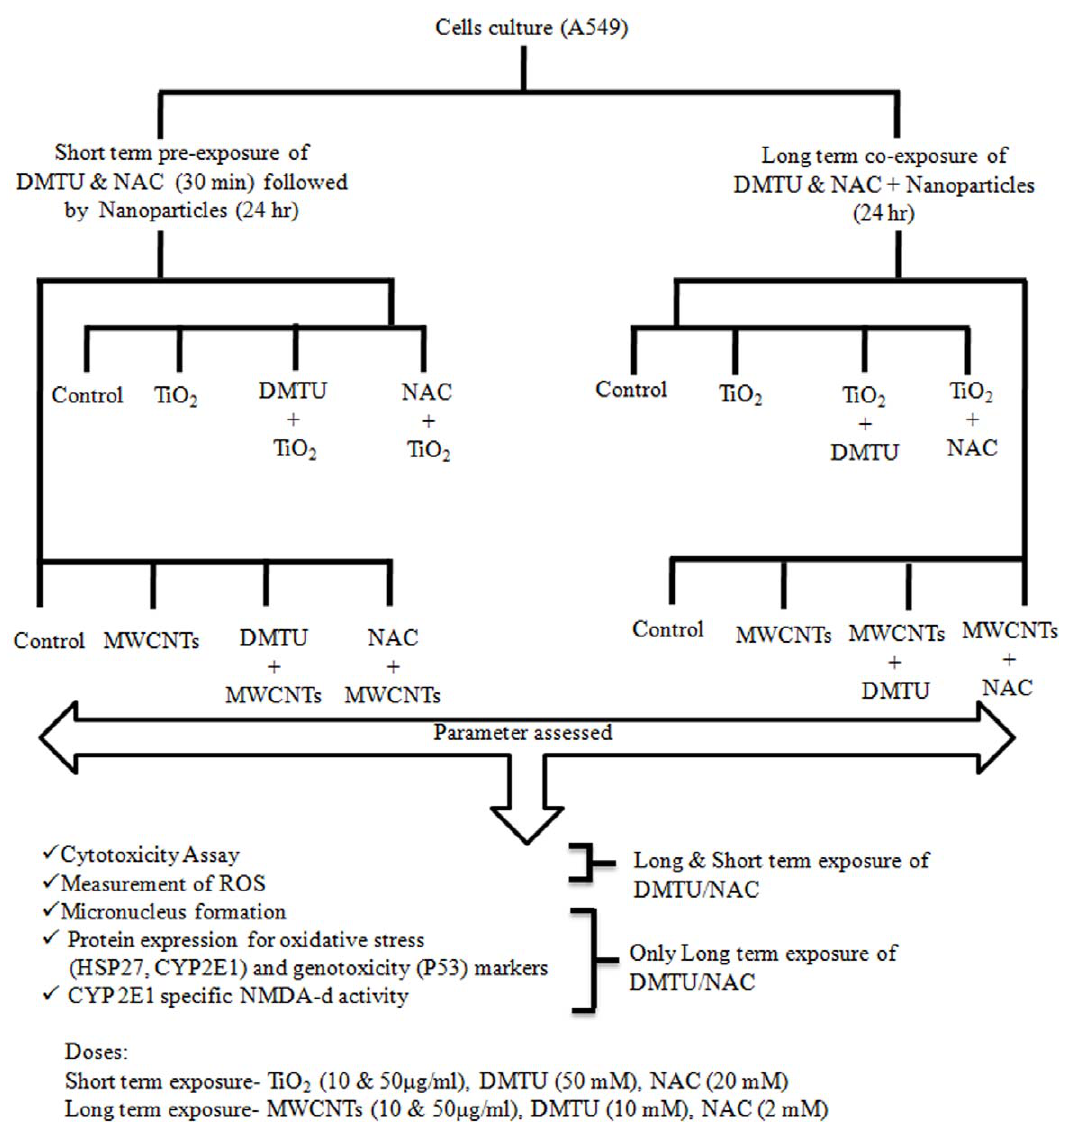
Figure 8. Experimental design. Experimental design showing the exposure protocol of nanoparticles (TiO2-NPs and MWCNTs) and scavenges (DMTU and NAC), study groups and endpoints studied in human lung cancer